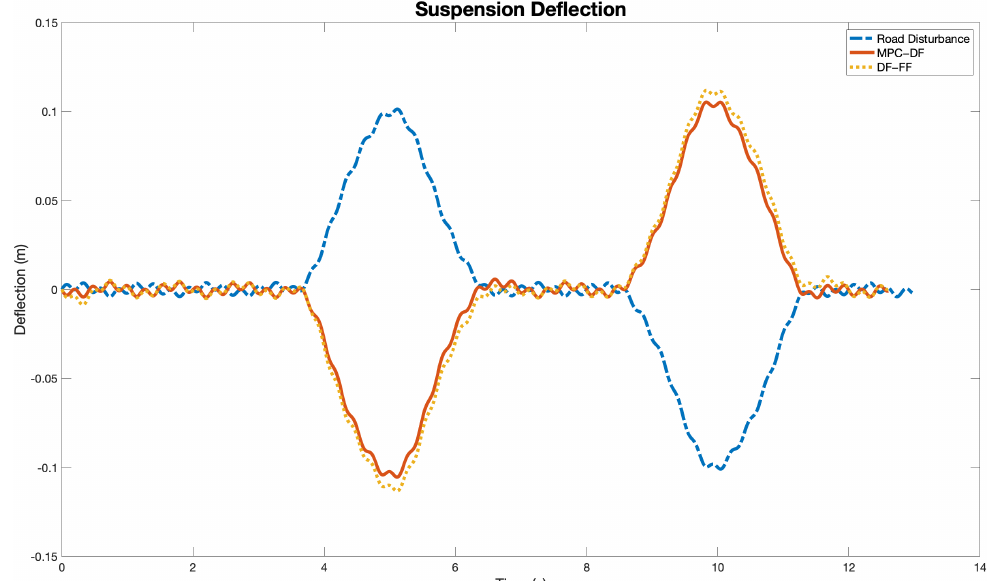
Figure 6. Suspension Deflection (Blue–Road Disturbance, Red–MPC-DF, Yellow–DF-FF).